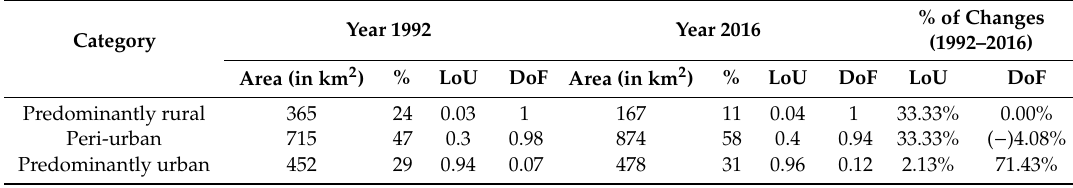
Table 5. Aerial statistics of peri-urban growth between 1992 and